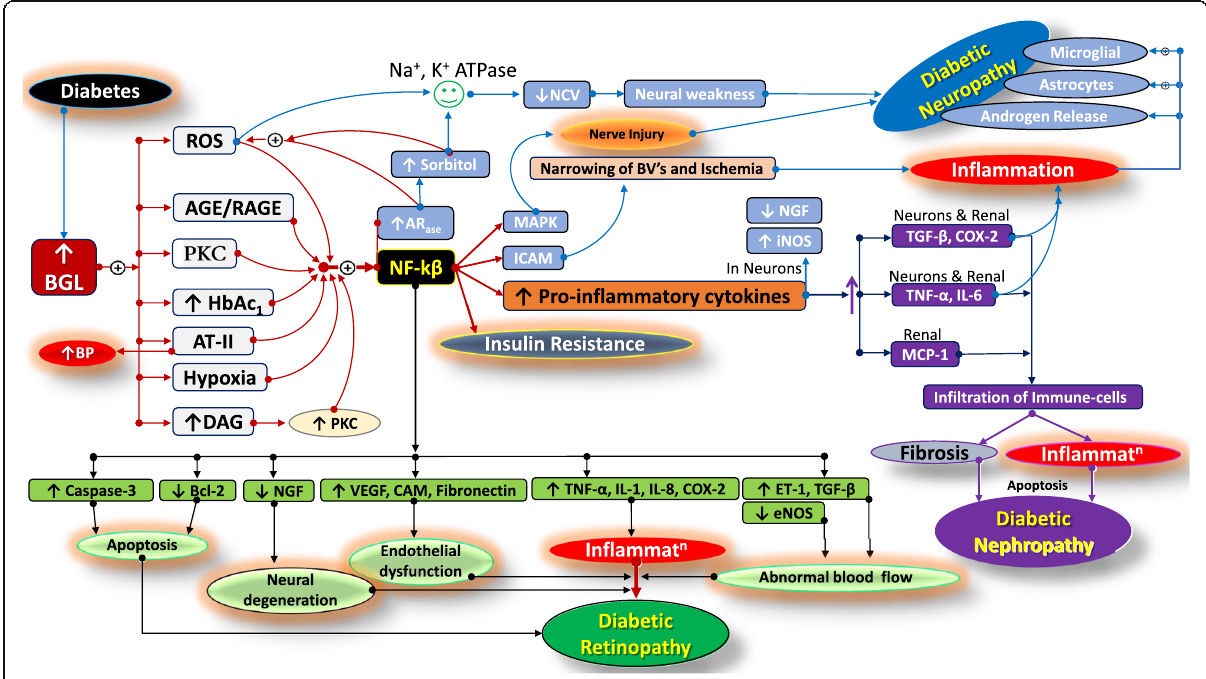
Fig. 2 Role of NF- κ B signaling pathway in diabetic complications.